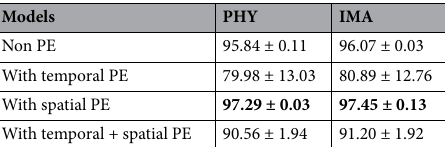
Table 4. Results of the ETST model with different position encoding. Significant values are in [bold].